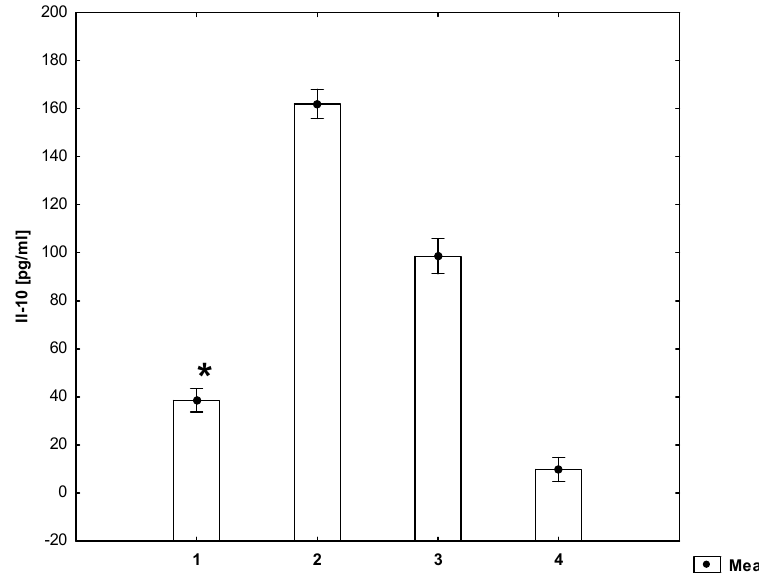
Figure 4. Concentrations of Il-10 in the cell culture supernatant (ANOVA). 1—cell suspension + mi- togen + homocysteine, 2—cell suspension + mitogen, 3—cell suspension, 4—medium. * statistically significant difference compared to every other group for p ≤ 0.05.